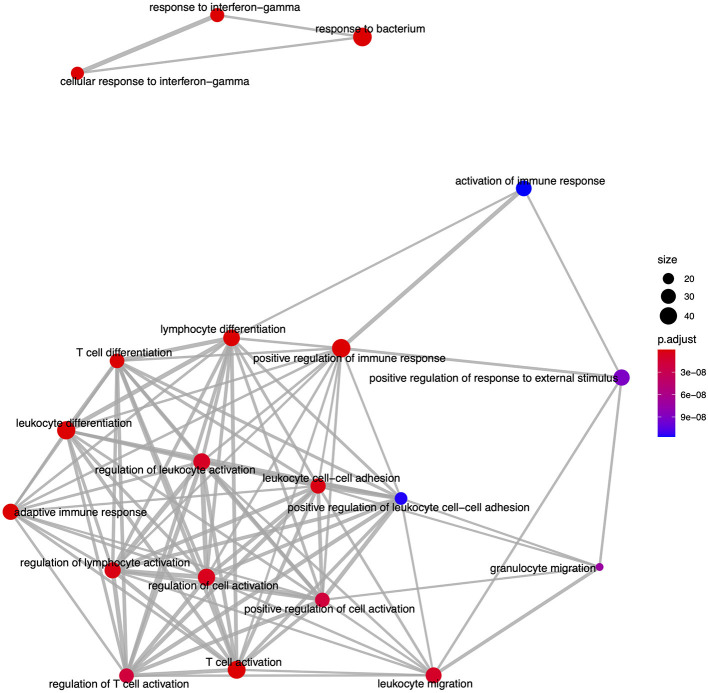
An enrichment map of genes overlapping the top 20 most significant GO biological process ontology terms enriched among differentially expressed genes in FP. The size of each node represents the number of genes differentially expressed in that ontology term, with thickness of edges between nodes representing the number of genes overlapping. Node color represents the gene set enrichment analysis test statistic with Benjamini–Hochberg adjustment for multiple testing.